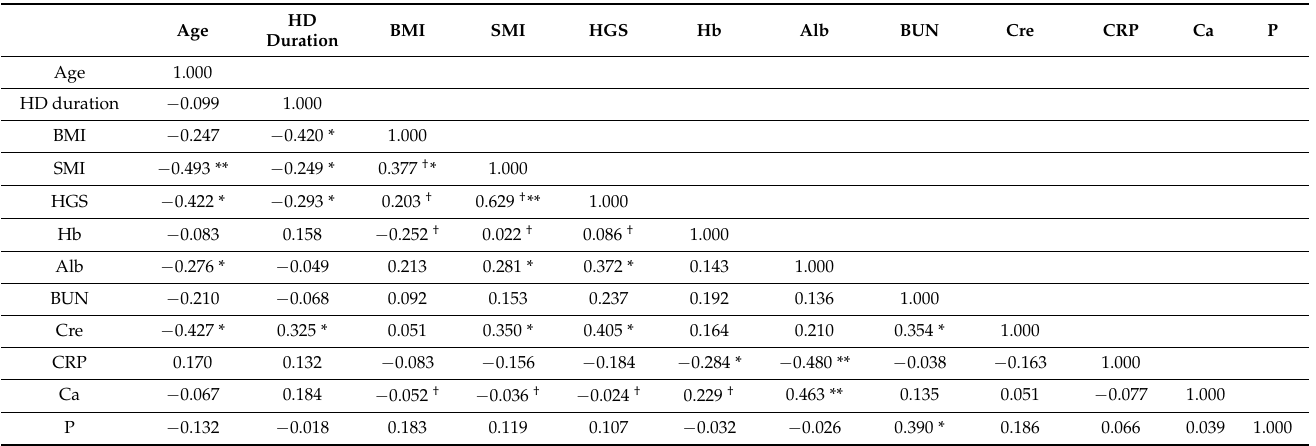
Table 2. Correlations between clinical parameters (excluding polyamine